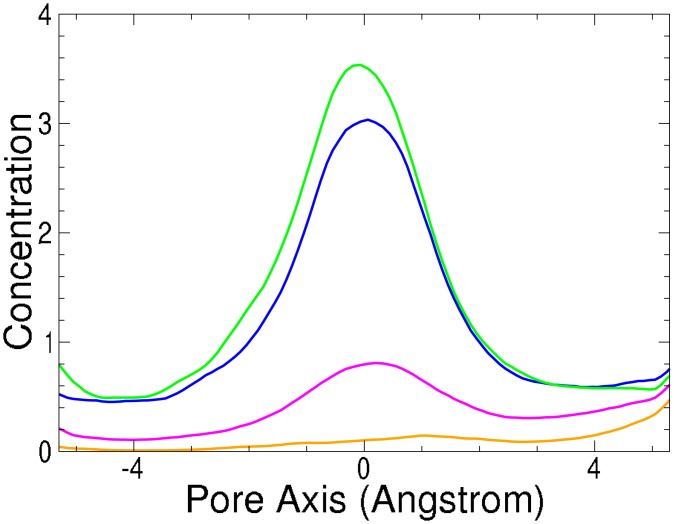
Simulated cation profile (as moving average over 2Å) in the Ca2+ (CavAb) ion channel SF.[Mn2+·X] green, [Ca2+·X] blue, [Na+·X] pink and [Ba2+·X] orange. Concentration minimum region used to calculate selectivity [−5.5 : −2.5].